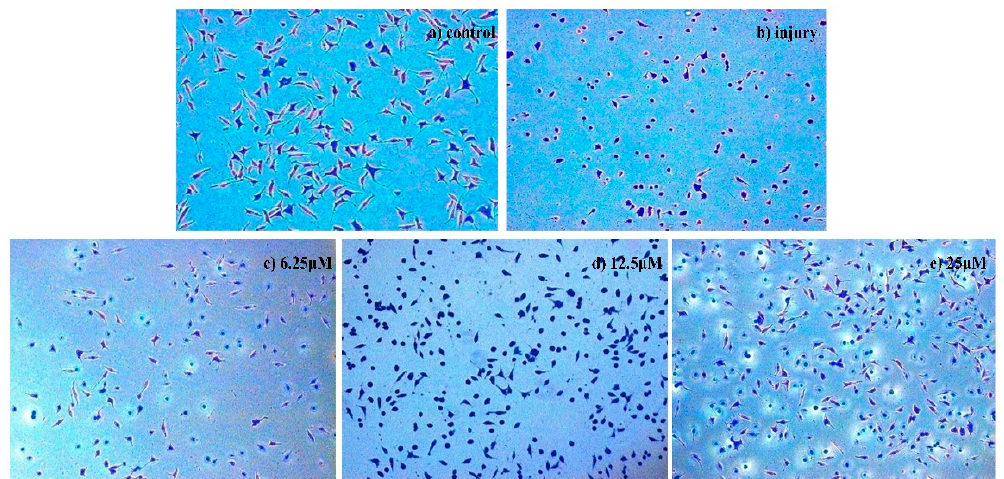
Figure 2. Morphological detection of apoptosis using Giemsa staining (200×) on injured SH-SY5Y cells treated with compound 8 : ( a ) control group, ( b ) injury group, ( c ) 6.25 μ M, ( d ) 12.5 μ M, and ( e ) 25 μ M.